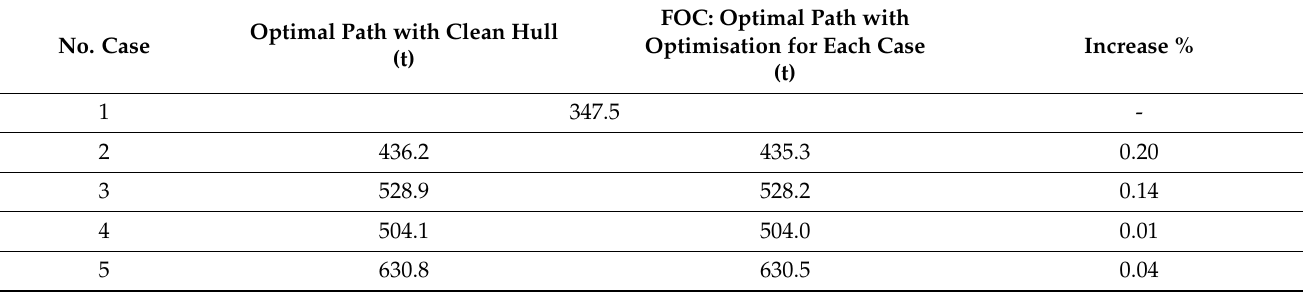
Table 4. Fuel oil consumption (FOC) for the optimal route found with a clean hull when investigating in other conditions.